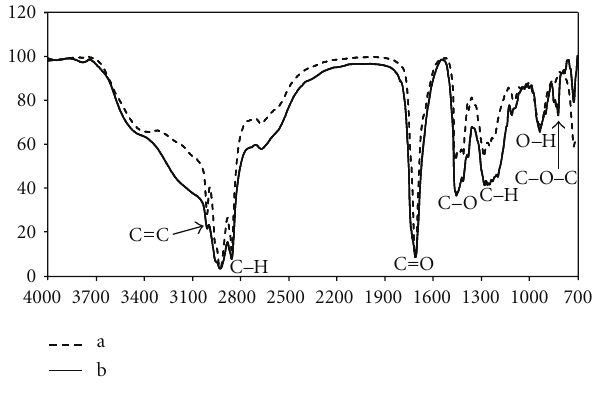
Figure 6: FTIR spectrum of the LA (a) and MEOA (b).